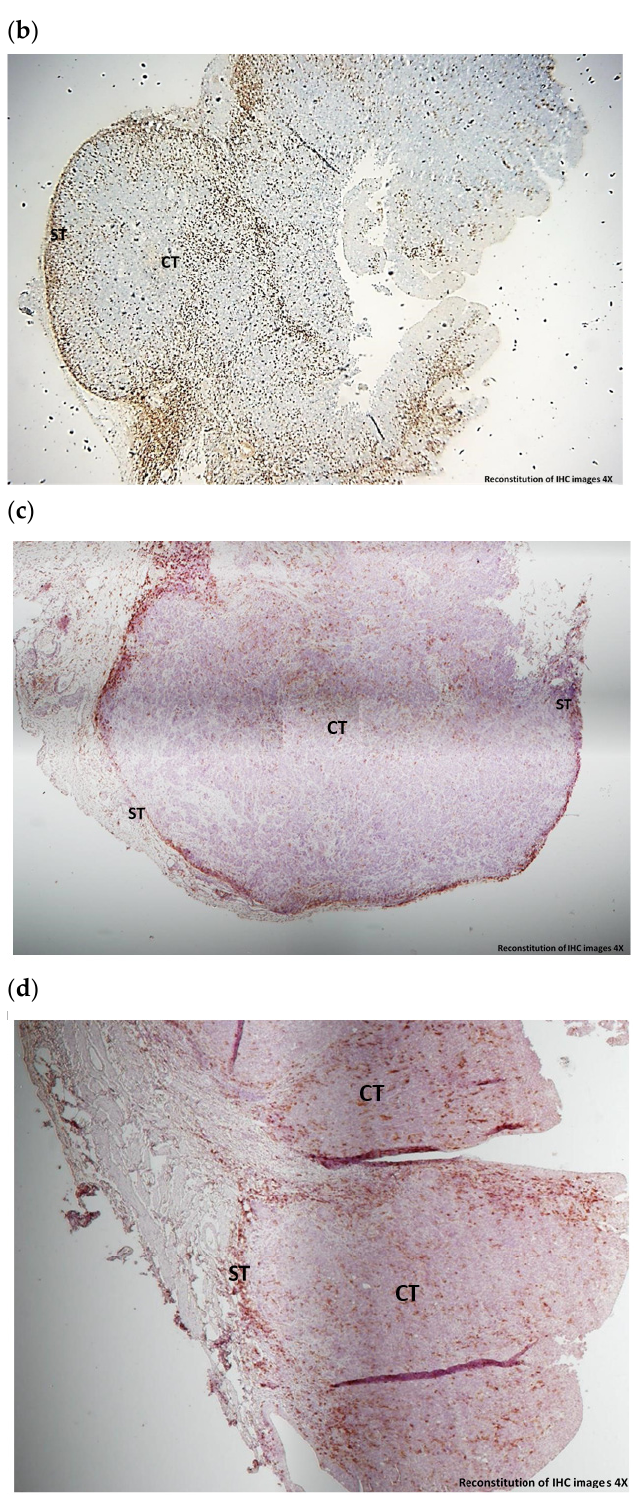
Figure 5. Typical images of CD3+ lymphocytes ( a , b ) and CD8+ lymphocytes ( c , d ) in bladder tumors 30 days post-grafting. ( a ) CD3+ lymphocytes in CTR BL sample displaying peripheral localization in stroma regions (ST) ( × 4); ( b ) CD3+ lymphocytes in HAL BL sample displaying localization around tumor cells in the center of tumor (CT) (×4); ( c ) CD8+ lymphocytes in CTR BL sample displaying peripheral localization in stroma regions (ST) ( × 10); ( d ) CD8+ lymphocytes in HAL BL sample displaying localization around tumor cells in the center of tumor (CT) ( ×